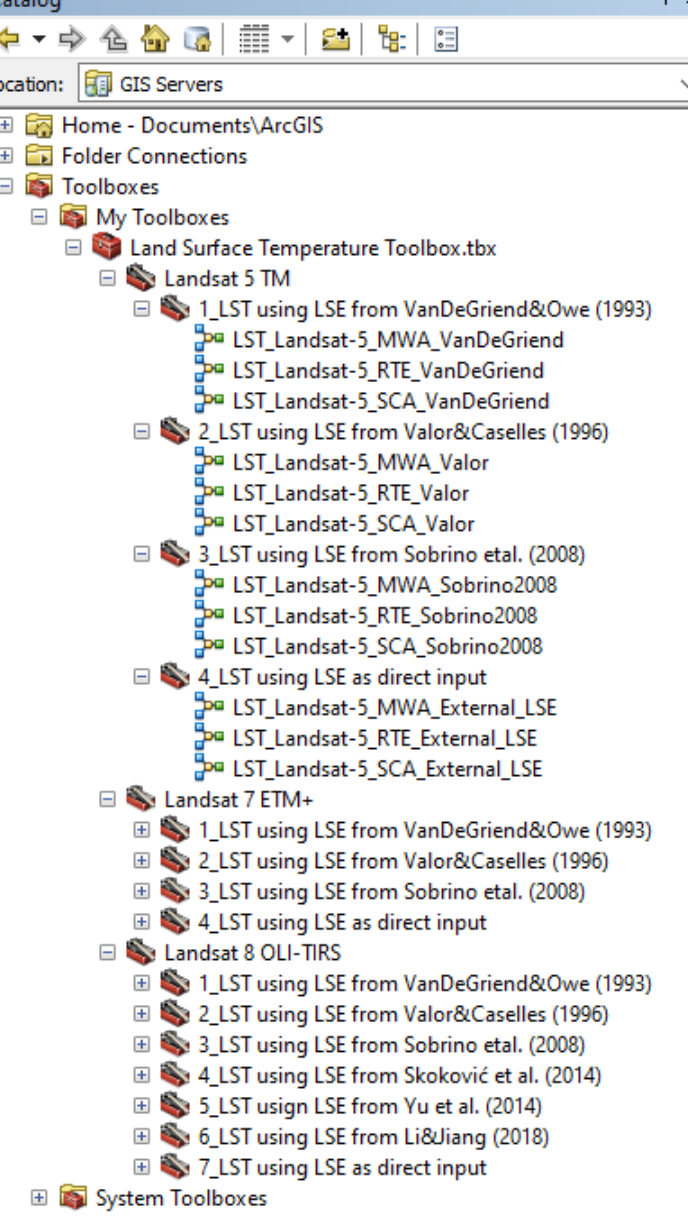
Figure F1. The interface of LST toolbox in the ArcGIS catalog window. Figure A1. The interface of LST toolbox in the ArcGIS catalog